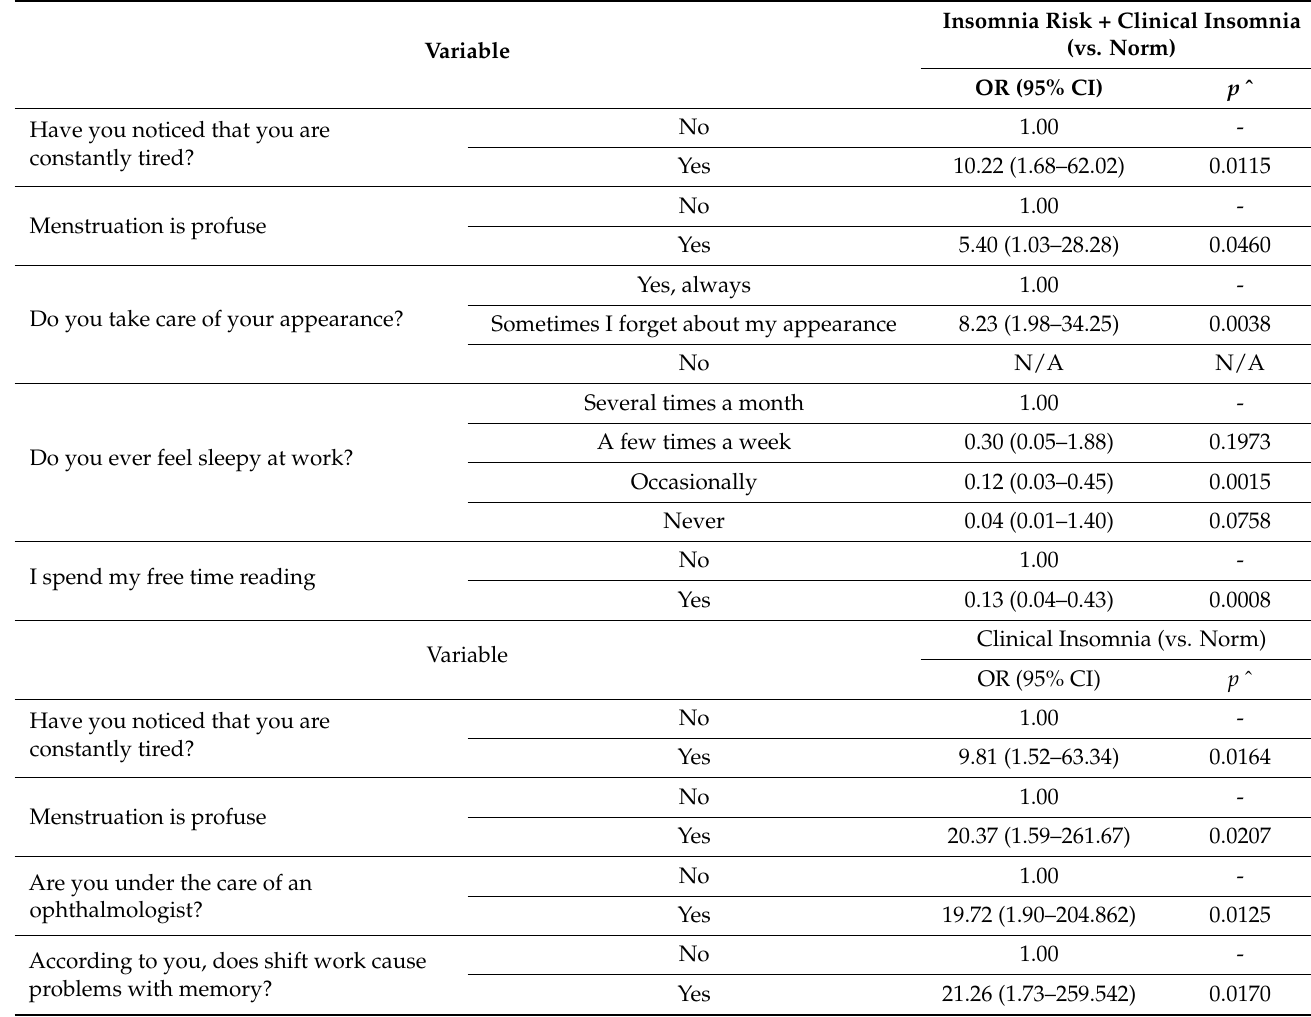
Table 13. Results of multivariate logistic regression performed in a group of female